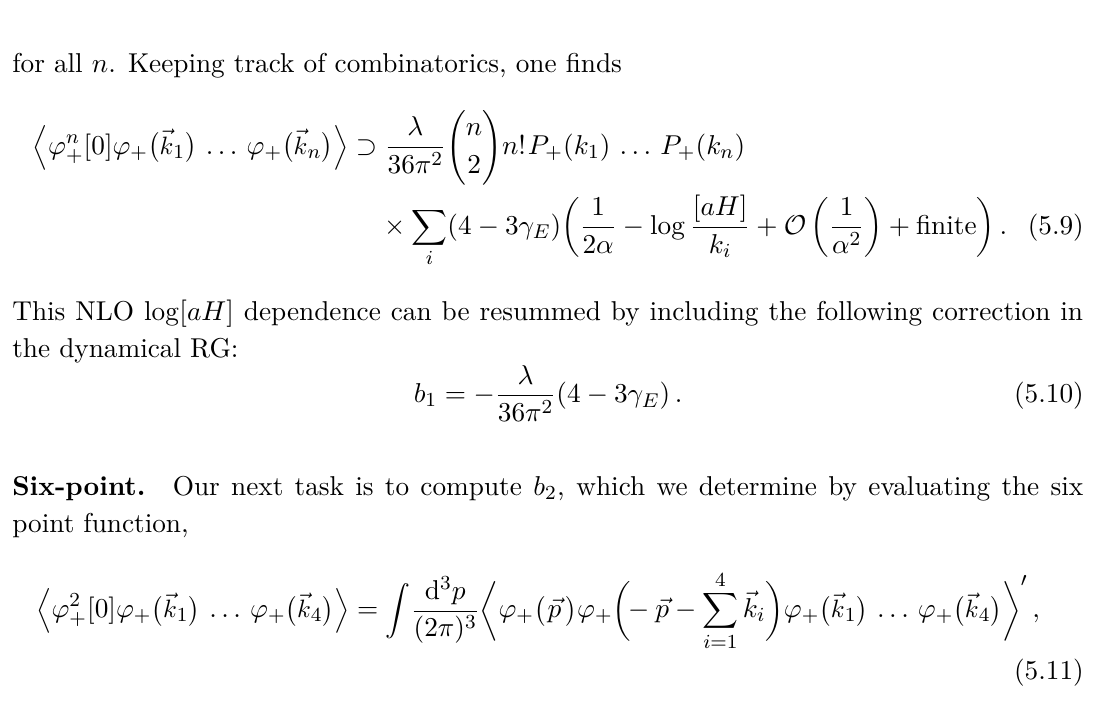
Figure 4 . One loop correction to ϕ 2 from the tree level trispectrum and integrate over two of the fields to form the composite operator . Left: the Witten diagram with a boundary at future infinity. Right: the Feynman diagram ϕ 2 + with the same momentum